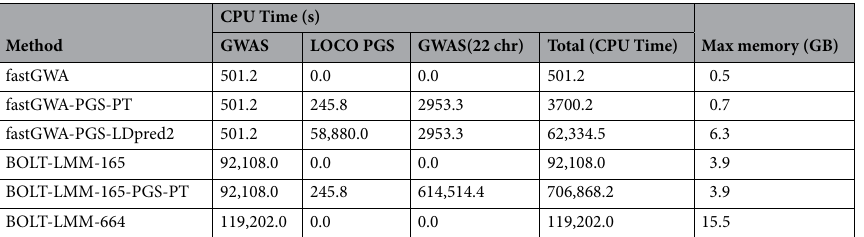
Table 1. Pipeline computation time and memory for simulations consisting of 100,000 individuals and 664,393 variants. Analyses were performed on a single compute node with 32 Xeon(R) CPU D-1541 CPUs and 128 GB of RAM. Note that REGENIE was omitted from the table, as the simulation is based on a single phenotype and would unfairly disadvantage REGENIE, which is optimized for the task of performing association analyses on multiple phenotypes